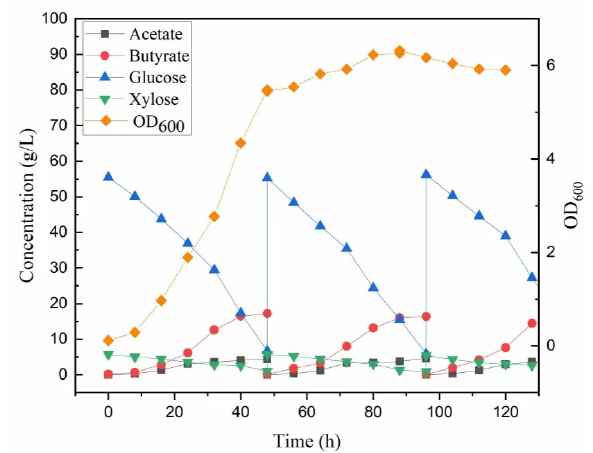
Figure 6. Performance of butyric acid production fed with hydrolysate in repeated-fed-batch mode.